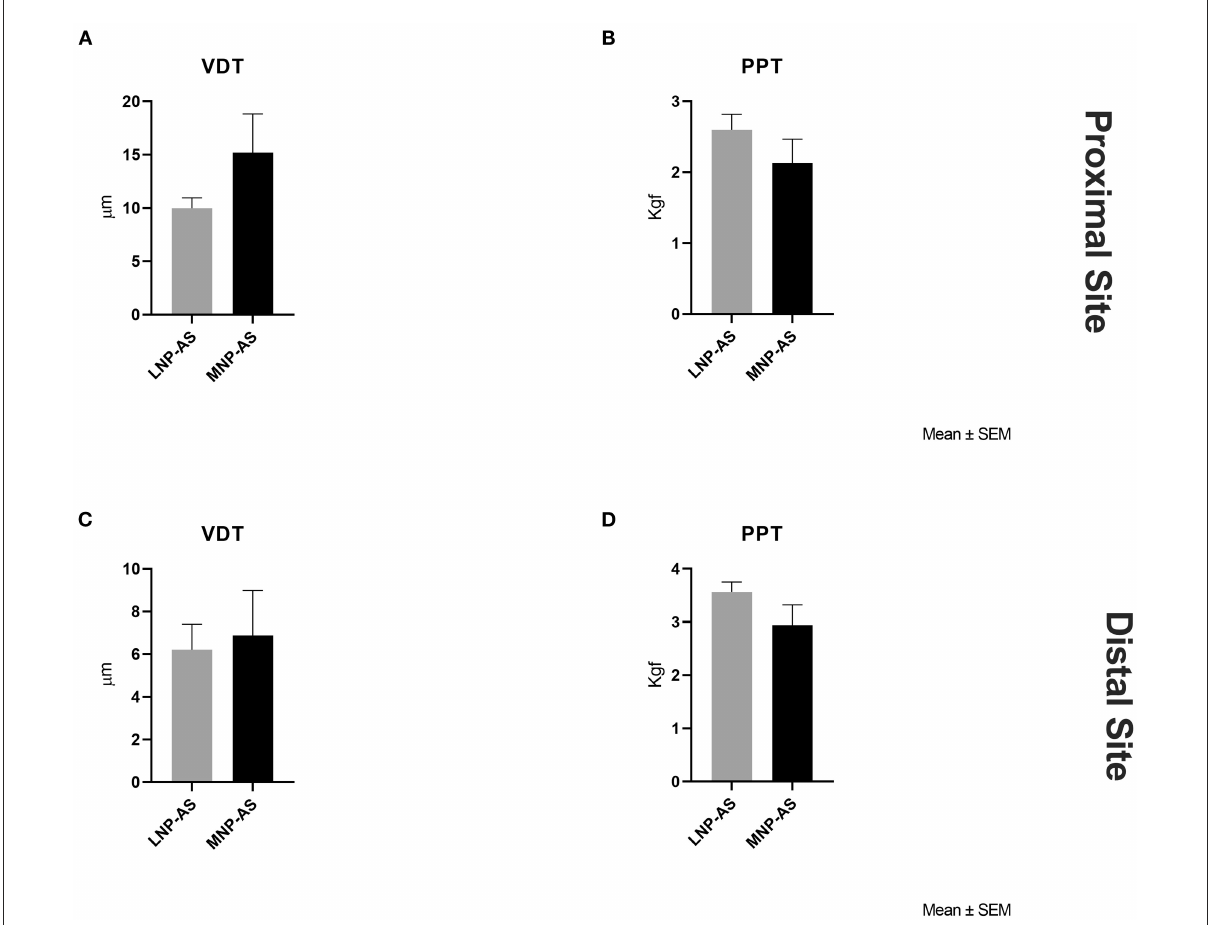
FIGURE3 Mechanical somatosensory factors obtained from QST. Group differences were not found with respect to (A) VDT (vibration detection threshold) on the proximal site, (B) PPT (pressure pain threshold) on the proximal site, (C) VDT on the distal site, and (D) PPT on the distal site between the LNP-AS (low or no neuropathic pain-anxiety symptoms) and MNP-AS (moderate neuropathic pain-anxiety